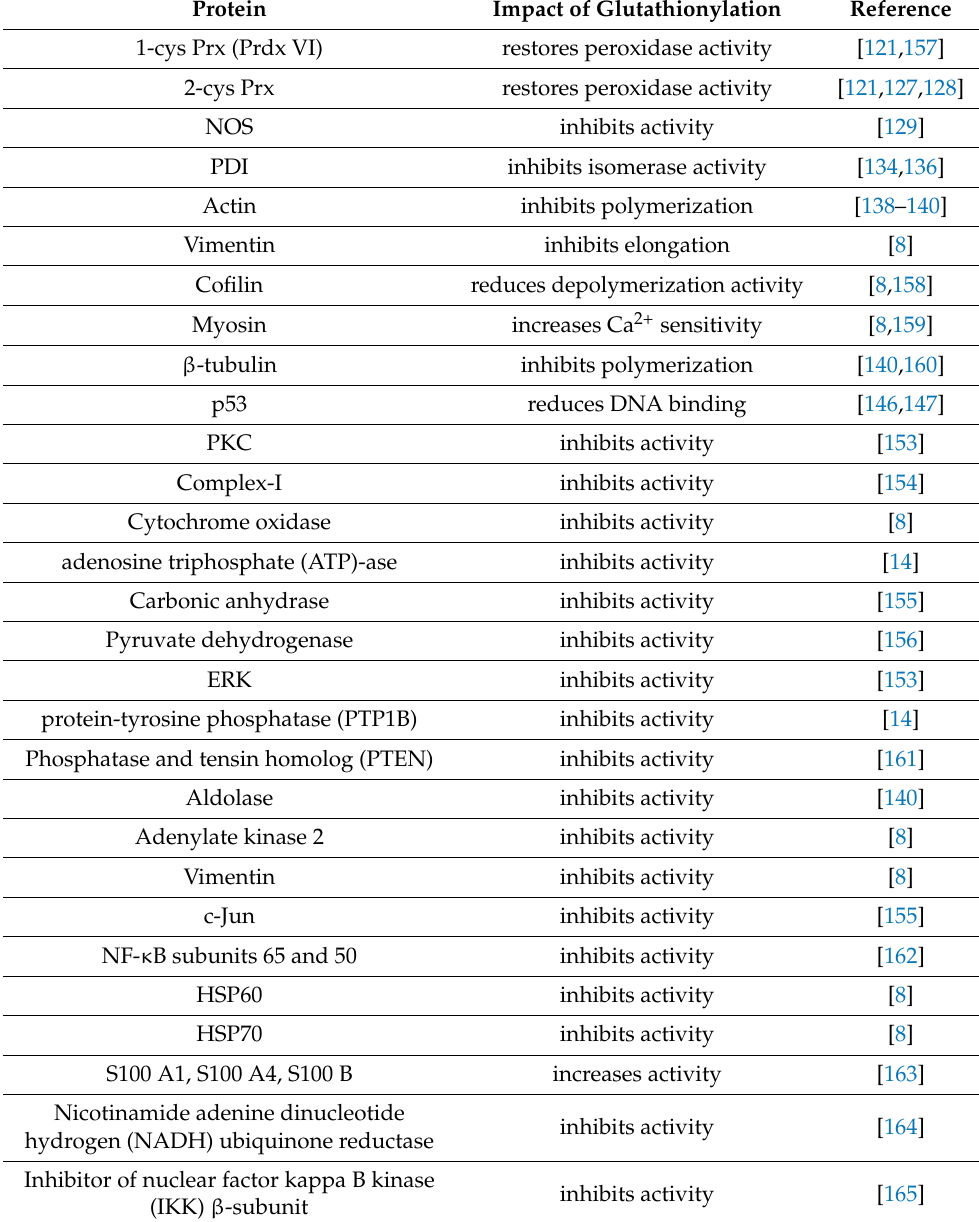
Table 2. Proteins that are susceptible to glutathionylation and the resulting effects on their activity are summarized below. Prx, peroxiredoxins; NOS, nitric oxide synthase; PDI, protein disulfide iso- merase; PKC, protein kinase C; ERK, extracellular signal-regulated kinase; GAPDH, glyceraldehyde- 3-phosphate